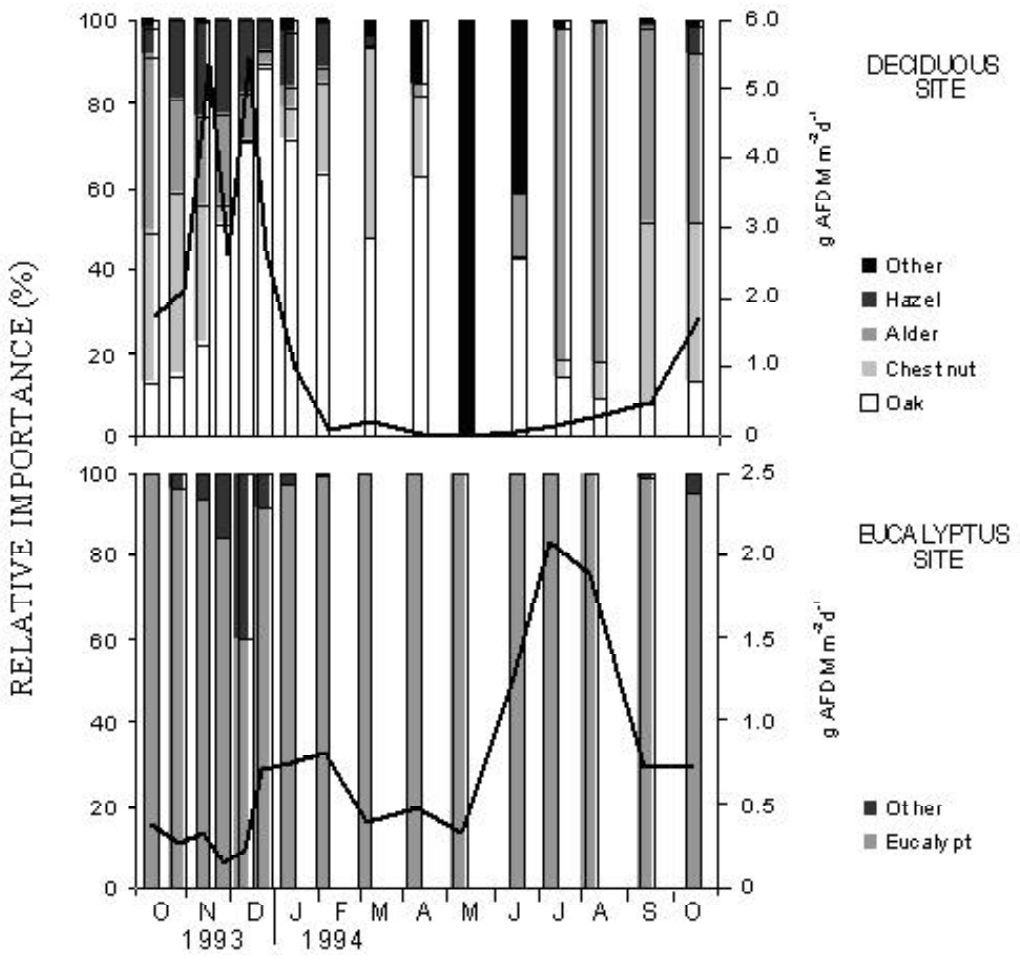
FIGURE 1. Temporal variation in leaf-litter (line) and in the relative importance of the main leaf species (bars) entering the streams (one deciduous and one eucalypt plantation) in the Agüera basin (northern